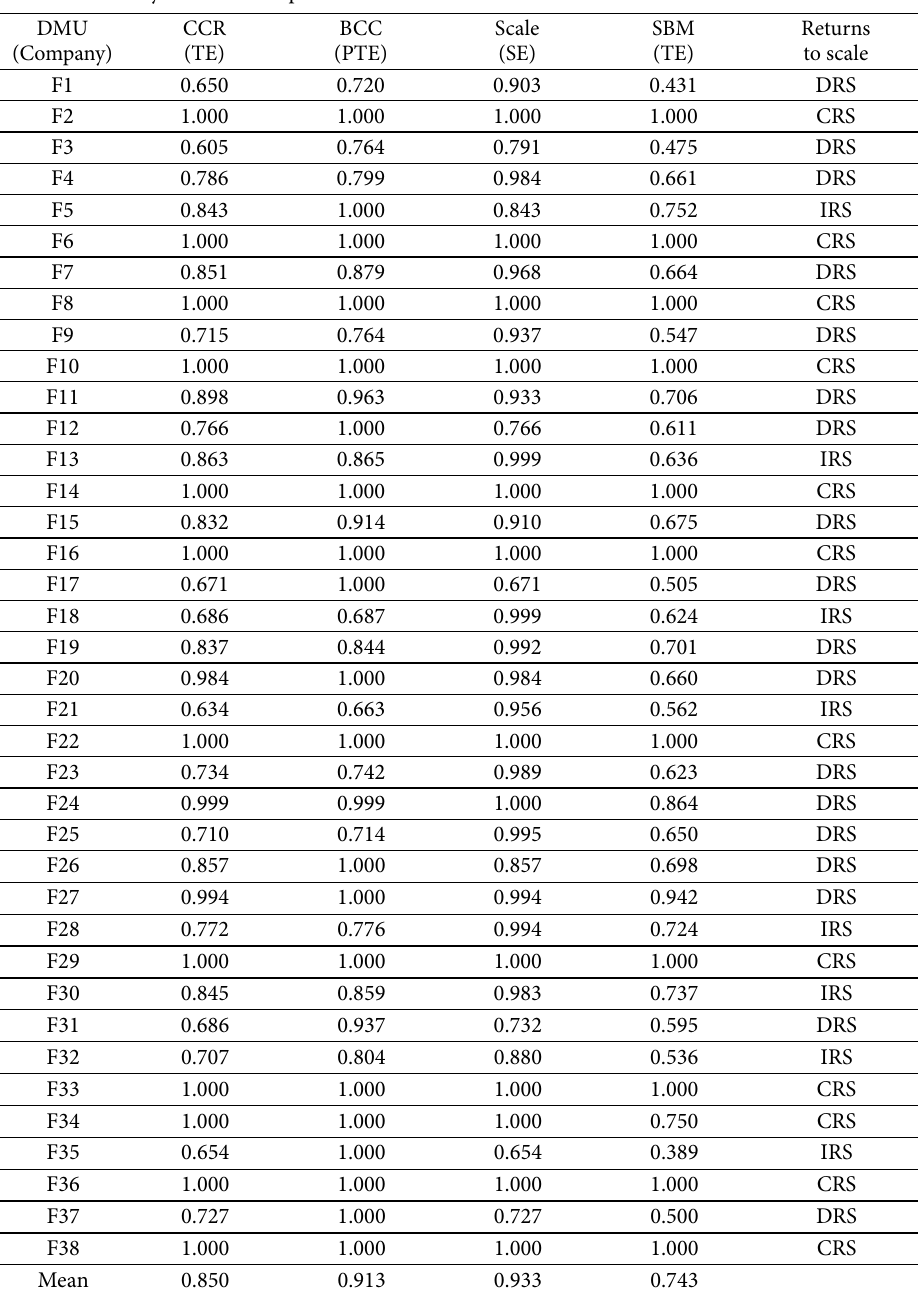
Table 4. Efficiency values of companies based on CCR and BCC